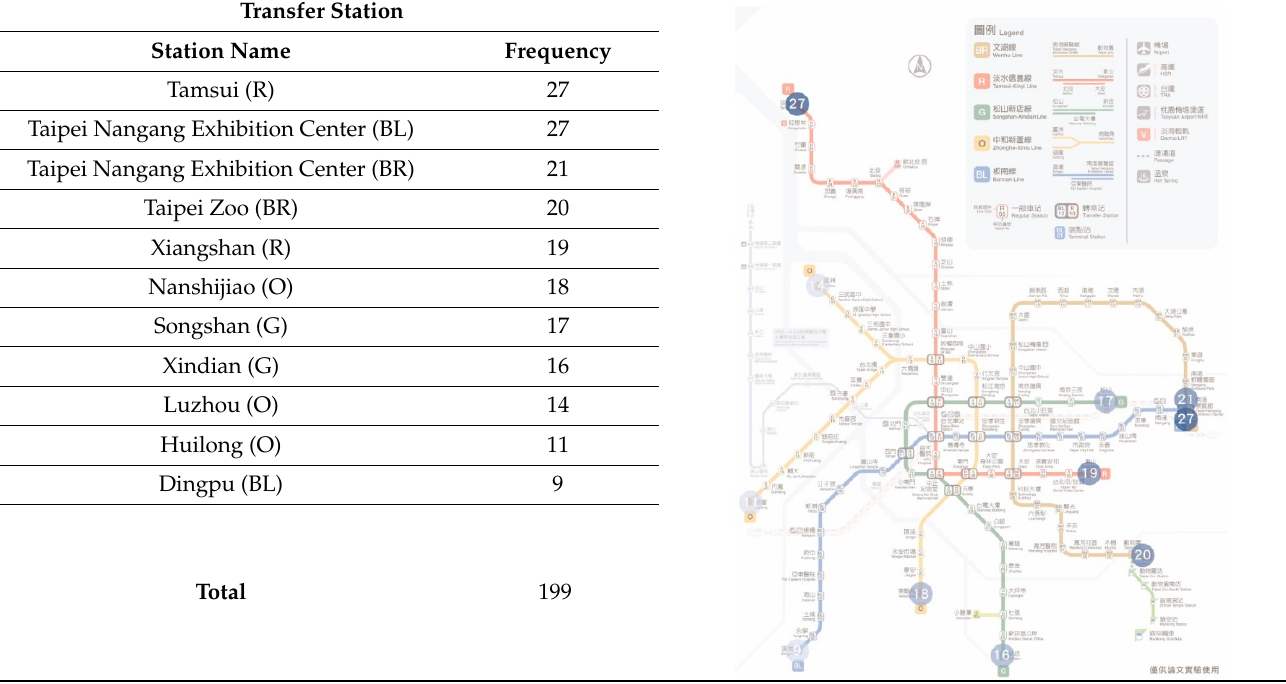
Table 5. Frequency and distribution of terminal stations as a drawing element.